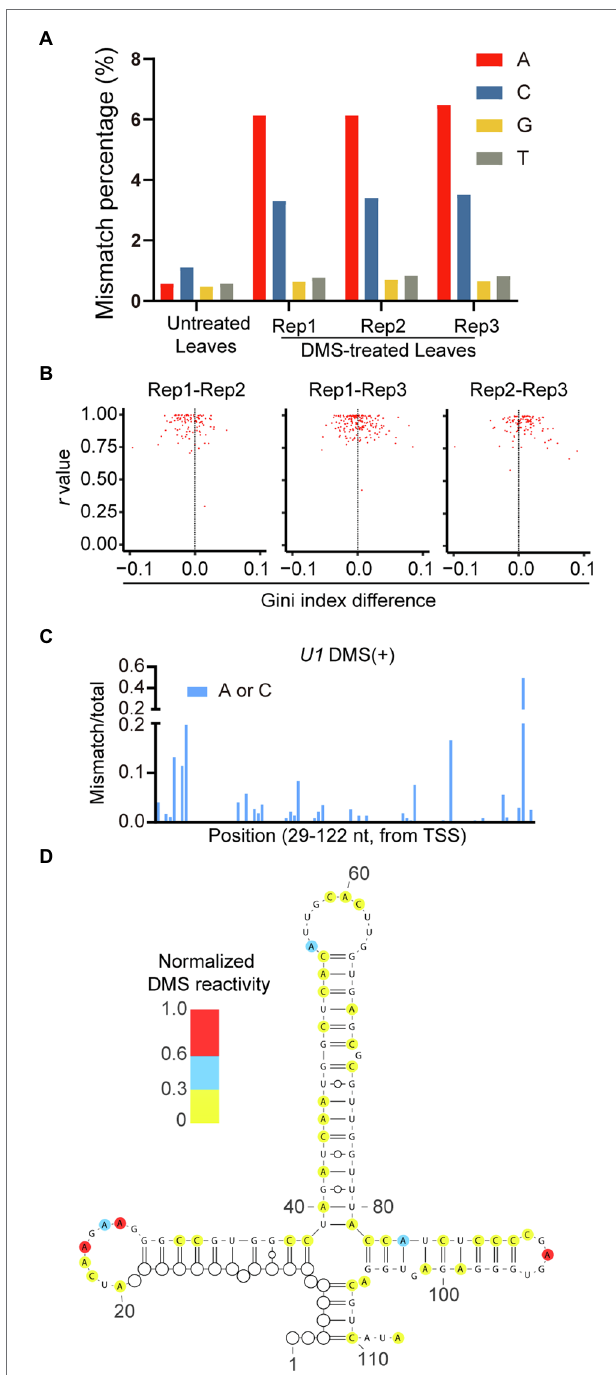
FIGURE 5 | High-quality of genome-wide DMS-MaPseq data in rice. (A) Total mismatch percentage on each nucleotide in untreated and DMS-treated samples. (B) Reproducibility between DMS-treated biological repeats were measured by Pearson’s r value and Gini index. (C) Ratiometric DMS signals of each A and C were plotted along U1 snRNA sequence. (D) The RNA secondary structure of 4-way junction region of U1 snRNA was predicted based on DMS- MaPseq data. The ratiometric DMS signal per position normalized to the highest mismatch/total in the displayed region, which was set arbitrarily to 1.0. White cycles indicated nucleotides without read